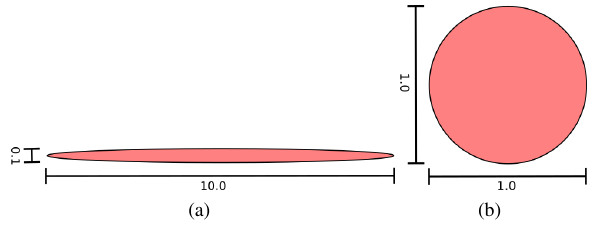
Figure 3. Both kernels have the same generalized variance, since the product of their eigenvalues equals 1